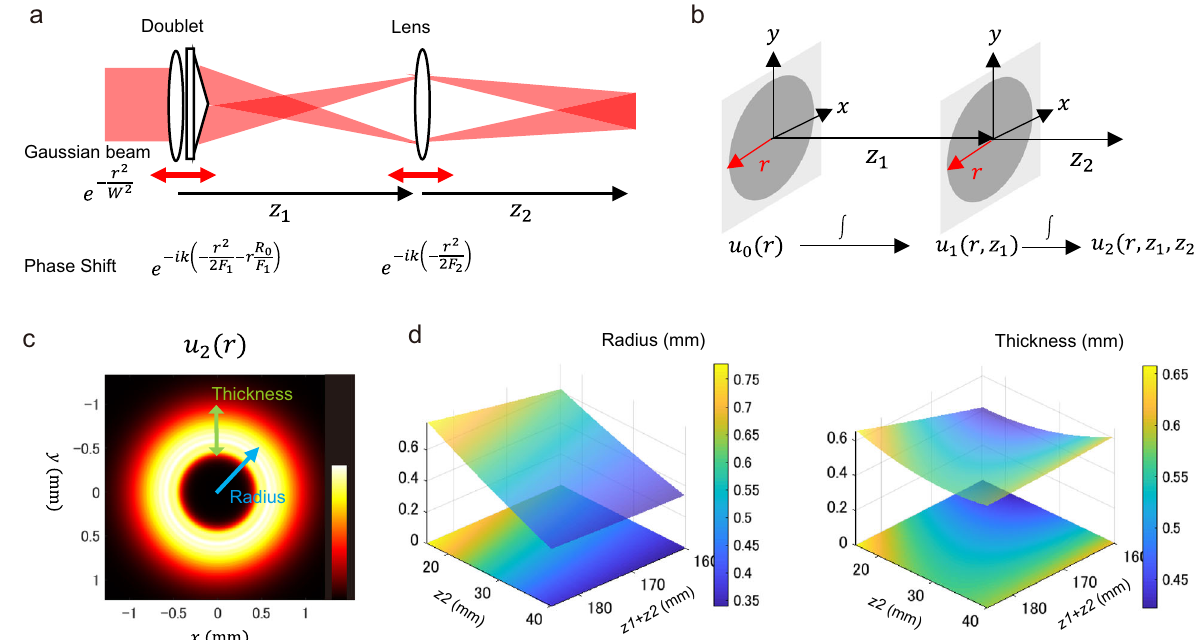
Fig. 1 Simulation of the lens-axicon triplet. a Schematic representation of the lens-axicon triplet. Gaussian-shaped laser line is transmitted to the optical unit from left to right. Lens-axicon doublet and a (second) lens can move translationally along the optical axis (red double-headed arrow). Distance between the doublet and the second lens, and that from the second lens are denoted as z 1 and z 2 , respectively. Phase shifts caused by transmission of the doublet and lens are indicated. b Illustration of the cylindrical coordinate system. z- Direction is set as the optical axis, and the xy plane is set transverse to the z -axis. c Transverse pro fi les through the optical unit ( z 1 ¼ 125 mm and z 2 ¼ 30 mm). Parameters (thickness and radius) are measured to characterize the annulus pattern. Radius is de fi ned as the distance between the origin and the maximum intensity point in the radial direction. Thickness is de fi ned as the full width at the half maximum (FWHM) of the distribution in radial direction. d Lens and doublet position dependence of the annulus parameters, radius, and thickness estimated by the 2nd order multiple regression